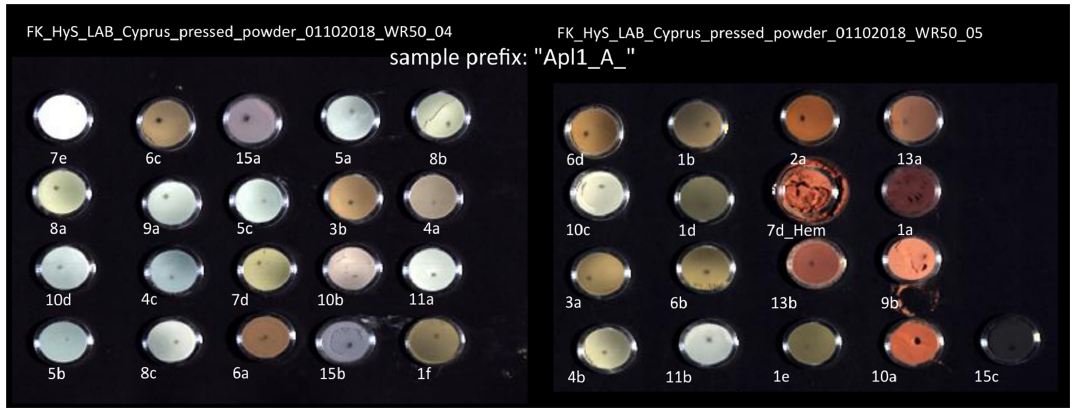
Figure 5. Showing the Apliki mine samples prepared as powder tablets. Table 2. HySpex settings for laboratory measurements of the REO and REMin (Koerting et al., 2019a, modified following Bösche, 2015;